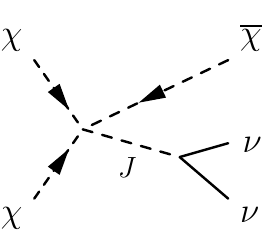
Figure 2 . Diagram of the neutrino production from the